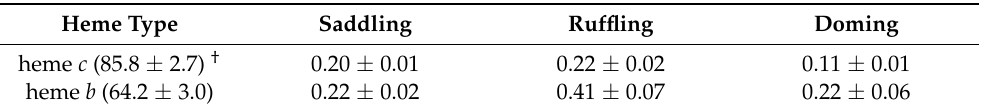
Table 3. The mean values and standard deviations of RMSE in angstroms between the observed and predicted values for each heme type. Heme Type Saddling Ruffling Doming heme c (85.8 ± 2.7)